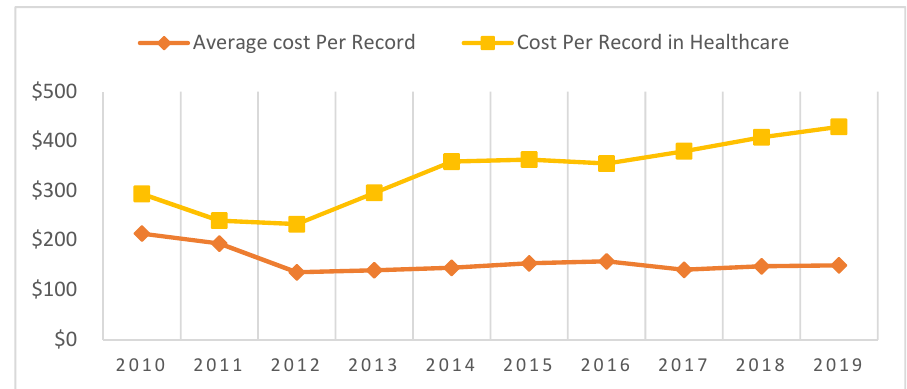
Figure 6. Graphical Comparison of Average Record Cost and Healthcare Record Cost.